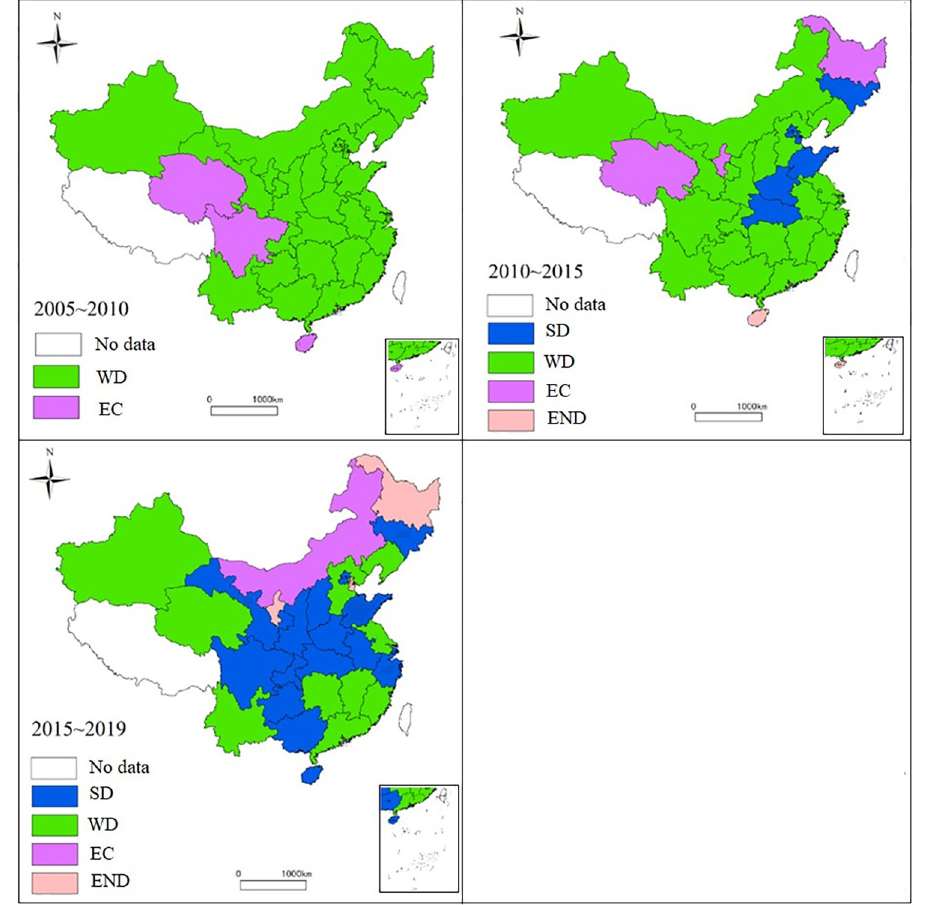
Fig 8. Decoupling pattern and type distribution of carbon emissions and economic growth. (Note: The original picture is from Natural Earth,